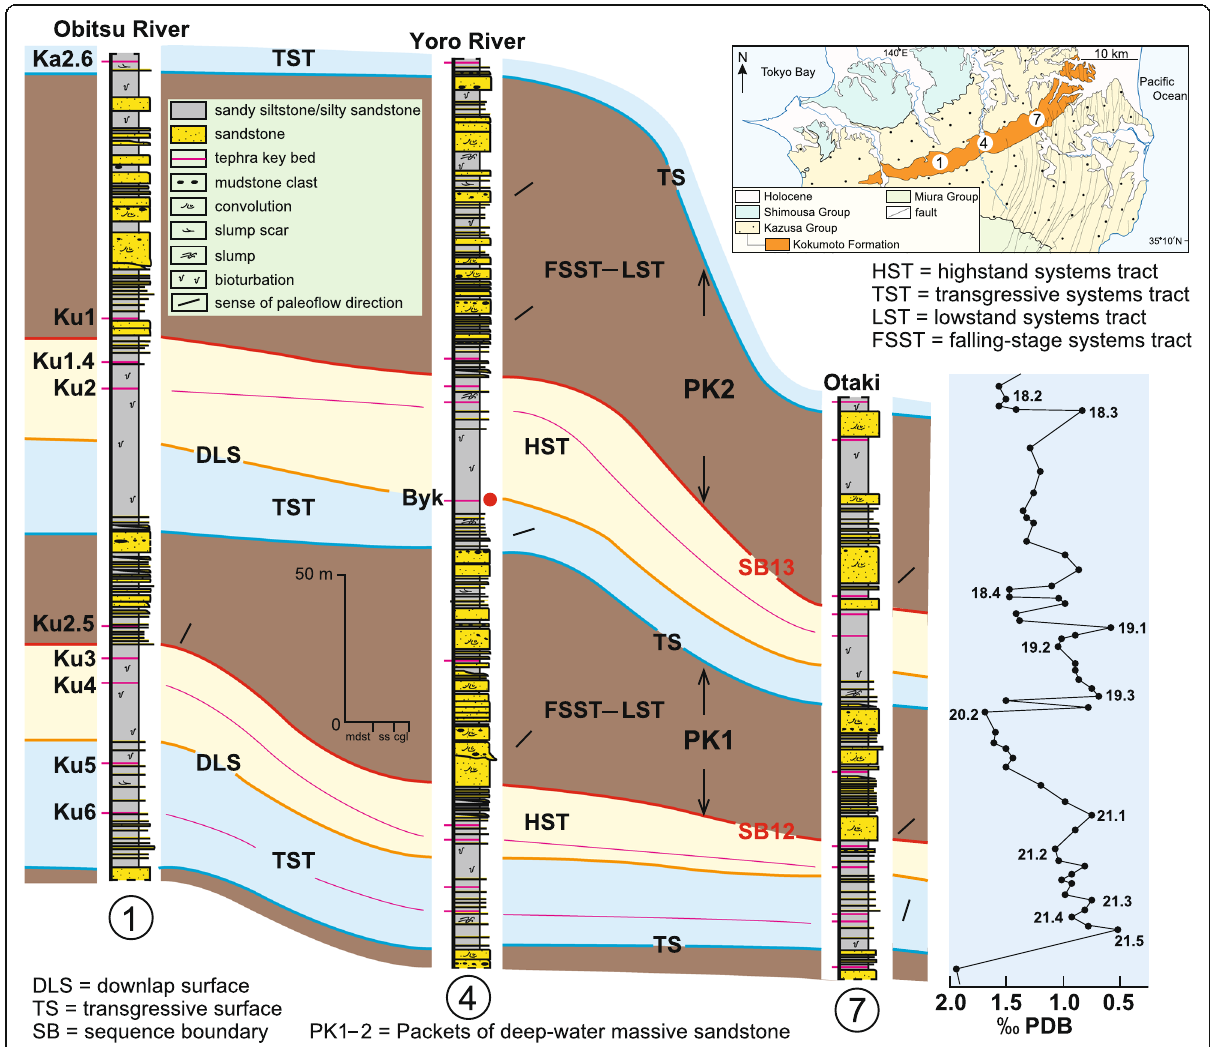
Fig. 4 Stratigraphic cross-section and sequence-stratigraphic classification of the Kokumoto Formation. The oxygen isotopic data are from Pickering et al. (1999) and are adjusted to stratigraphic section 7. The inset map shows the locations of the measured sections. Ku6 – Ka2.6 denote the coding of tephra key beds. The filled red circle on the right side of section 2 indicates a stratigraphic horizon approximately 110 cm above the Byakubi tephra key bed (Byk) (Byk-E in Suganuma et al. 2018) that is inferred to represent the Lower – Middle Pleistocene Subseries boundary. See Fig. S1 for the stratigraphic positions of SB12 and SB13 within the Kazusa